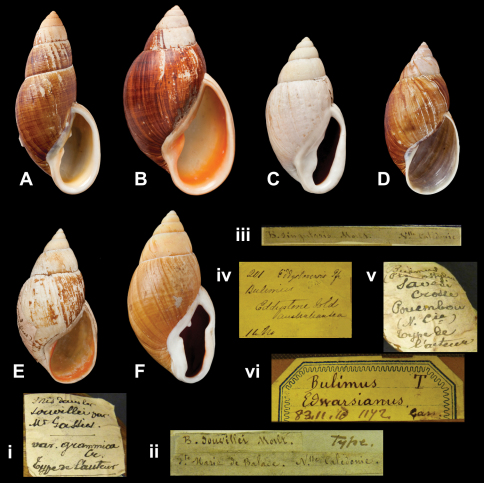
Placostylus species. A, i
Placostylus fibratus goroensis (Souverbie in Souverbie and Montrouzier, 1870), syntype of Bulimus fibratus grammica Crosse, 1870 NHM 1929.9.14.15 (H = 111.3) B, ii
Placostylus fibratus souvillei (Morelet, 1857), lectotype NHM 1893.2.4.1529 (H = 116.5) C, iii
Placostylus porphyrostomus porphyrostomus (Pfeiffer, 1851), holotype of Bulimus singularis Morelet, 1857 NHM 1893.2.4.1530 (H = 70.0) D, iv
Placostylus eddystonensis eddystonensis (Pfeiffer, 1855), lectotype NHM 1975230 (H = 73.3) E, v
Placostylus eddystonensis savesi (Crosse, 1886), holotype NHM 1929.9.14.7 (H = 57.5) F, vi
Placostylus caledonicus (Petit de la Saussaye, 1845), possible syntype of Bulimus edwardsianus Gassies, 1863 NHM 1883.11.10.1172 (H = 72.0). All reduced in size.